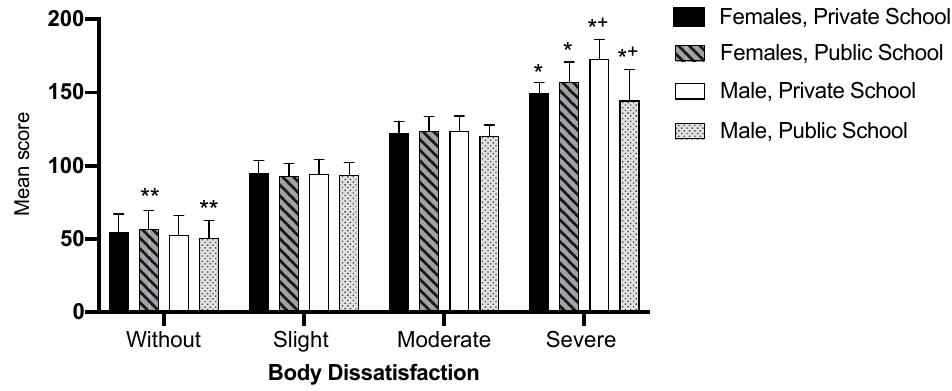
Figure 3. Degree of body dissatisfaction mean and standard deviation, by sex and school type. *— p < 0.05 statistically significant difference between sexes; **— p ≤ 0.001 statistically significant difference between sexes; +— p < 0.05 statistically significant difference between schools.